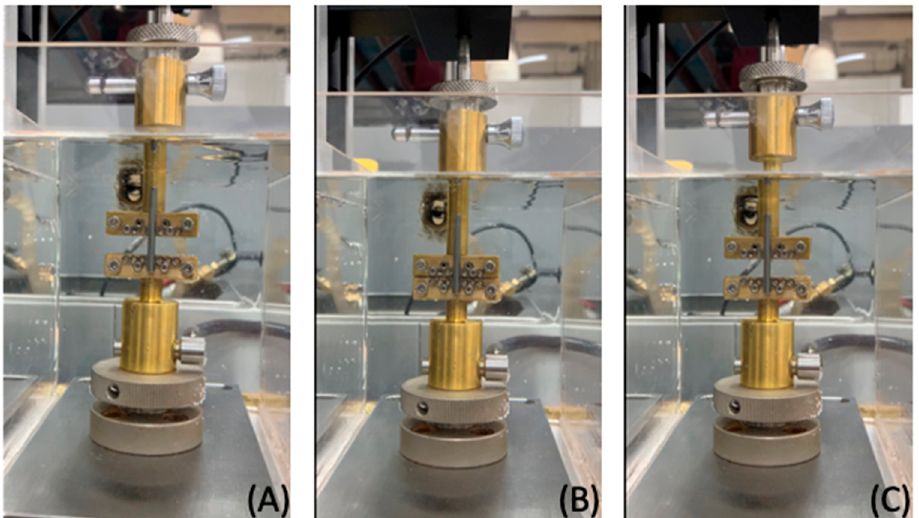
Figure 4. Experimental setup of the novel alveolar distractor for the compression–extension test. ( A ) Device configuration at the beginning of the experiment; ( B ) the upper grip compressing the springs downwards over 9.1 mm until the fixed and movable base plates were in contact; ( C ) the upper grip released upwards to the start position.